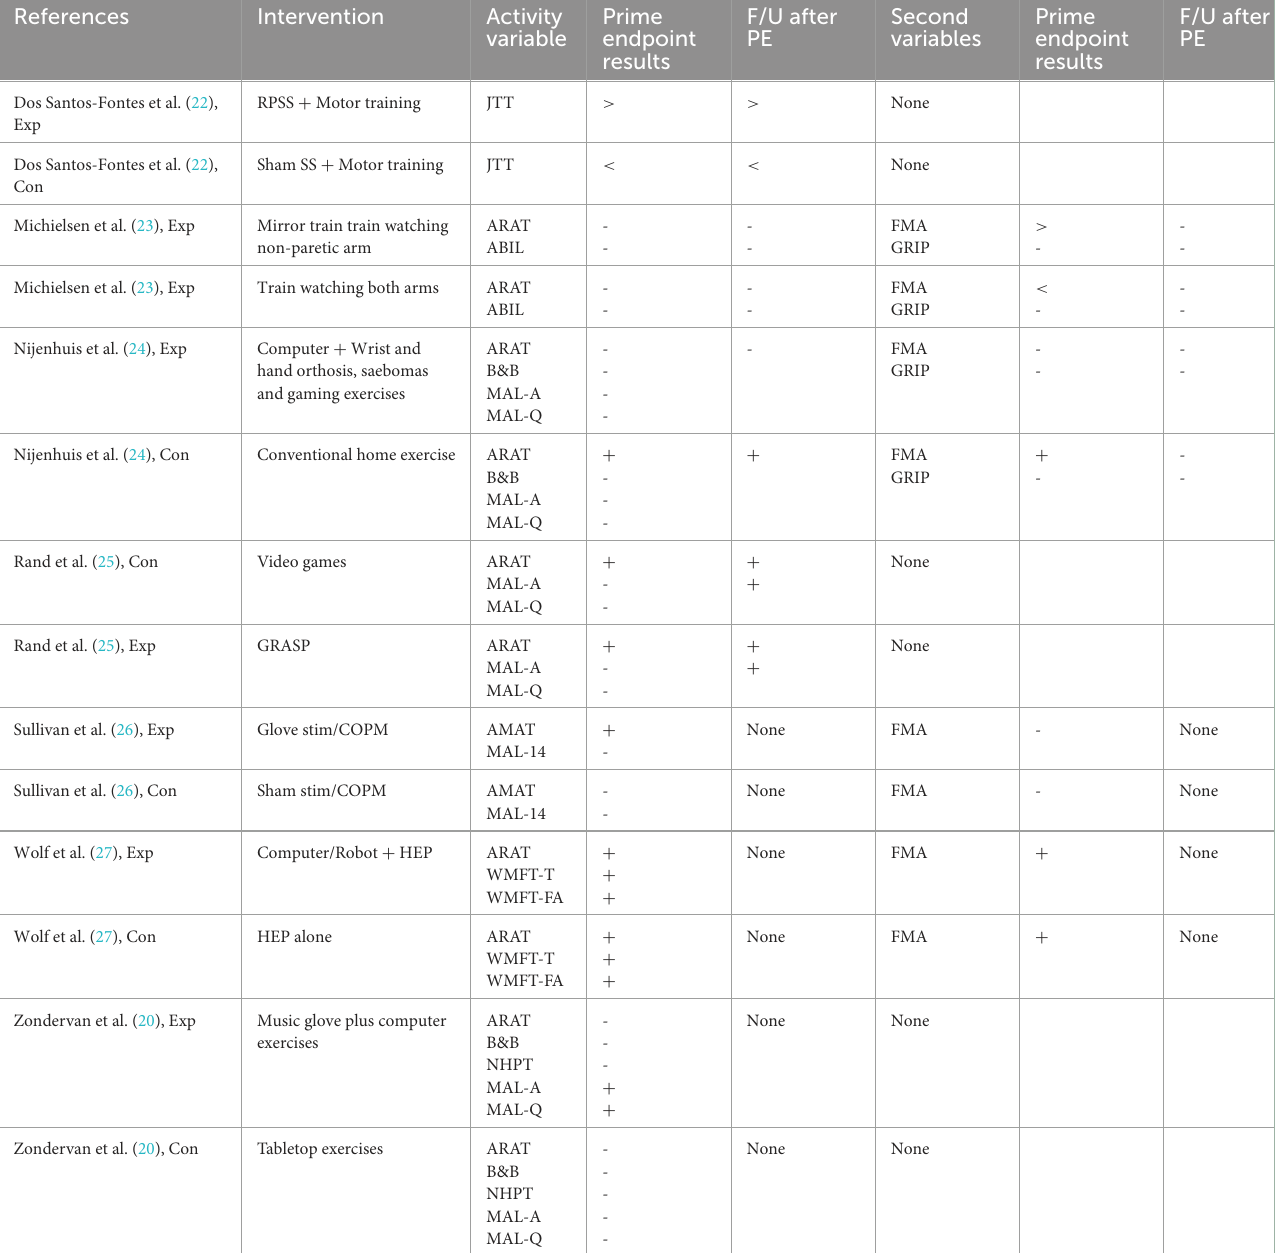
TABLE 3 Results for each home intervention program considered